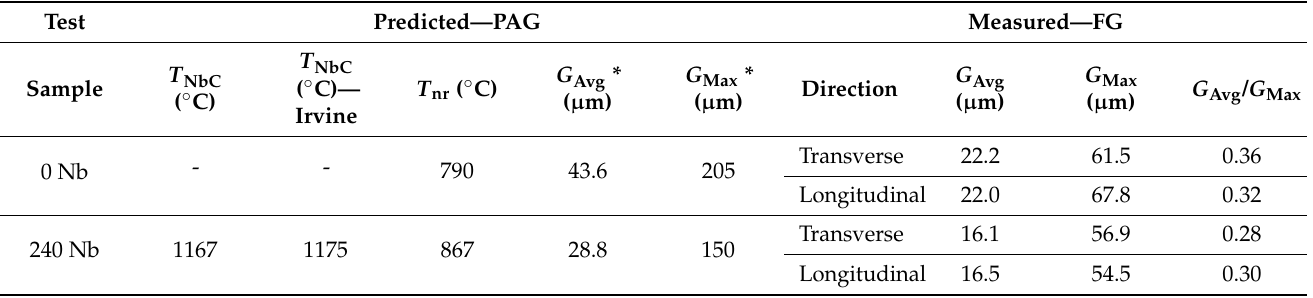
Table 2. Characteristic temperatures and austenite and ferrite grain sizes after phase